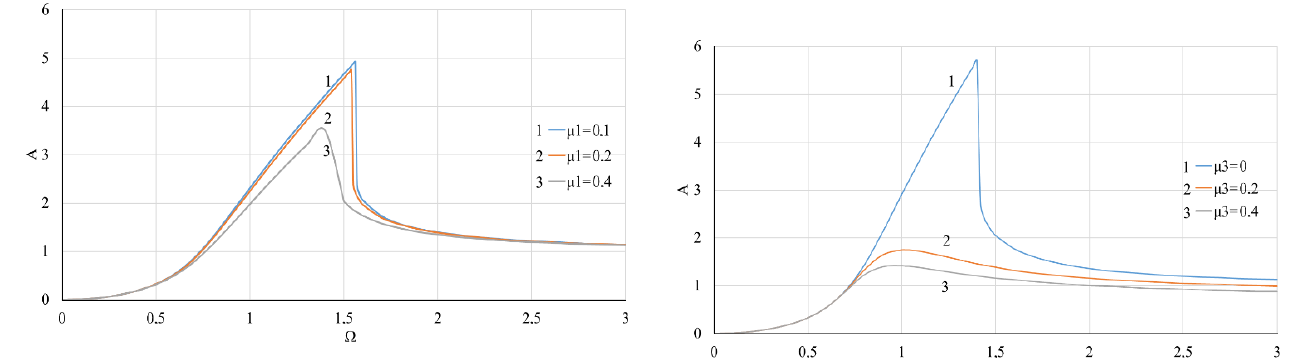
Figure 8. Dependence of the vibration amplitude A on the rotor ve- locity (cid:127) with nonlinear stiffness coefficient of the support K 3 = 0 . 1 and at different values of the coefficient of linear viscous damping µ 1 .